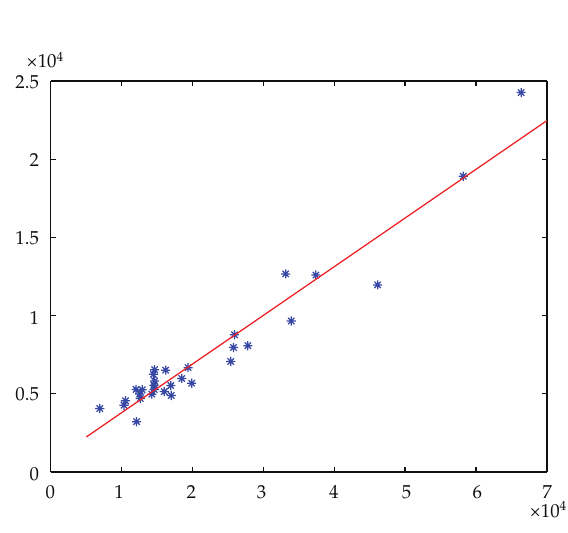
Figure 6: Residual plot.